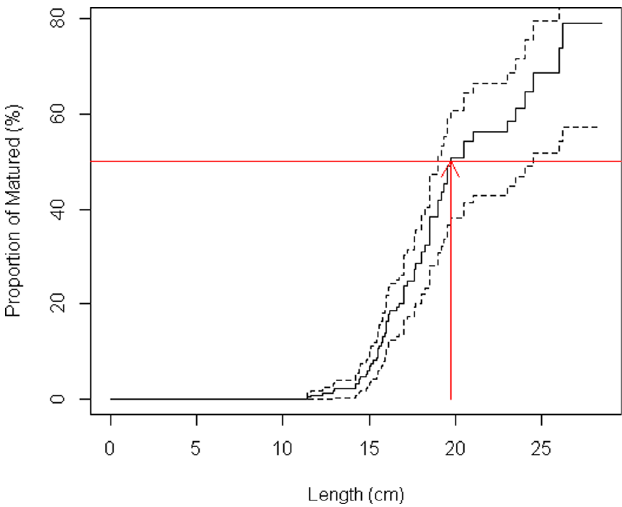
Fig. 8. Size at 50% maturity ( L M 50 ) of female J. coitor in river Ganga. Dotted lines represent 95%